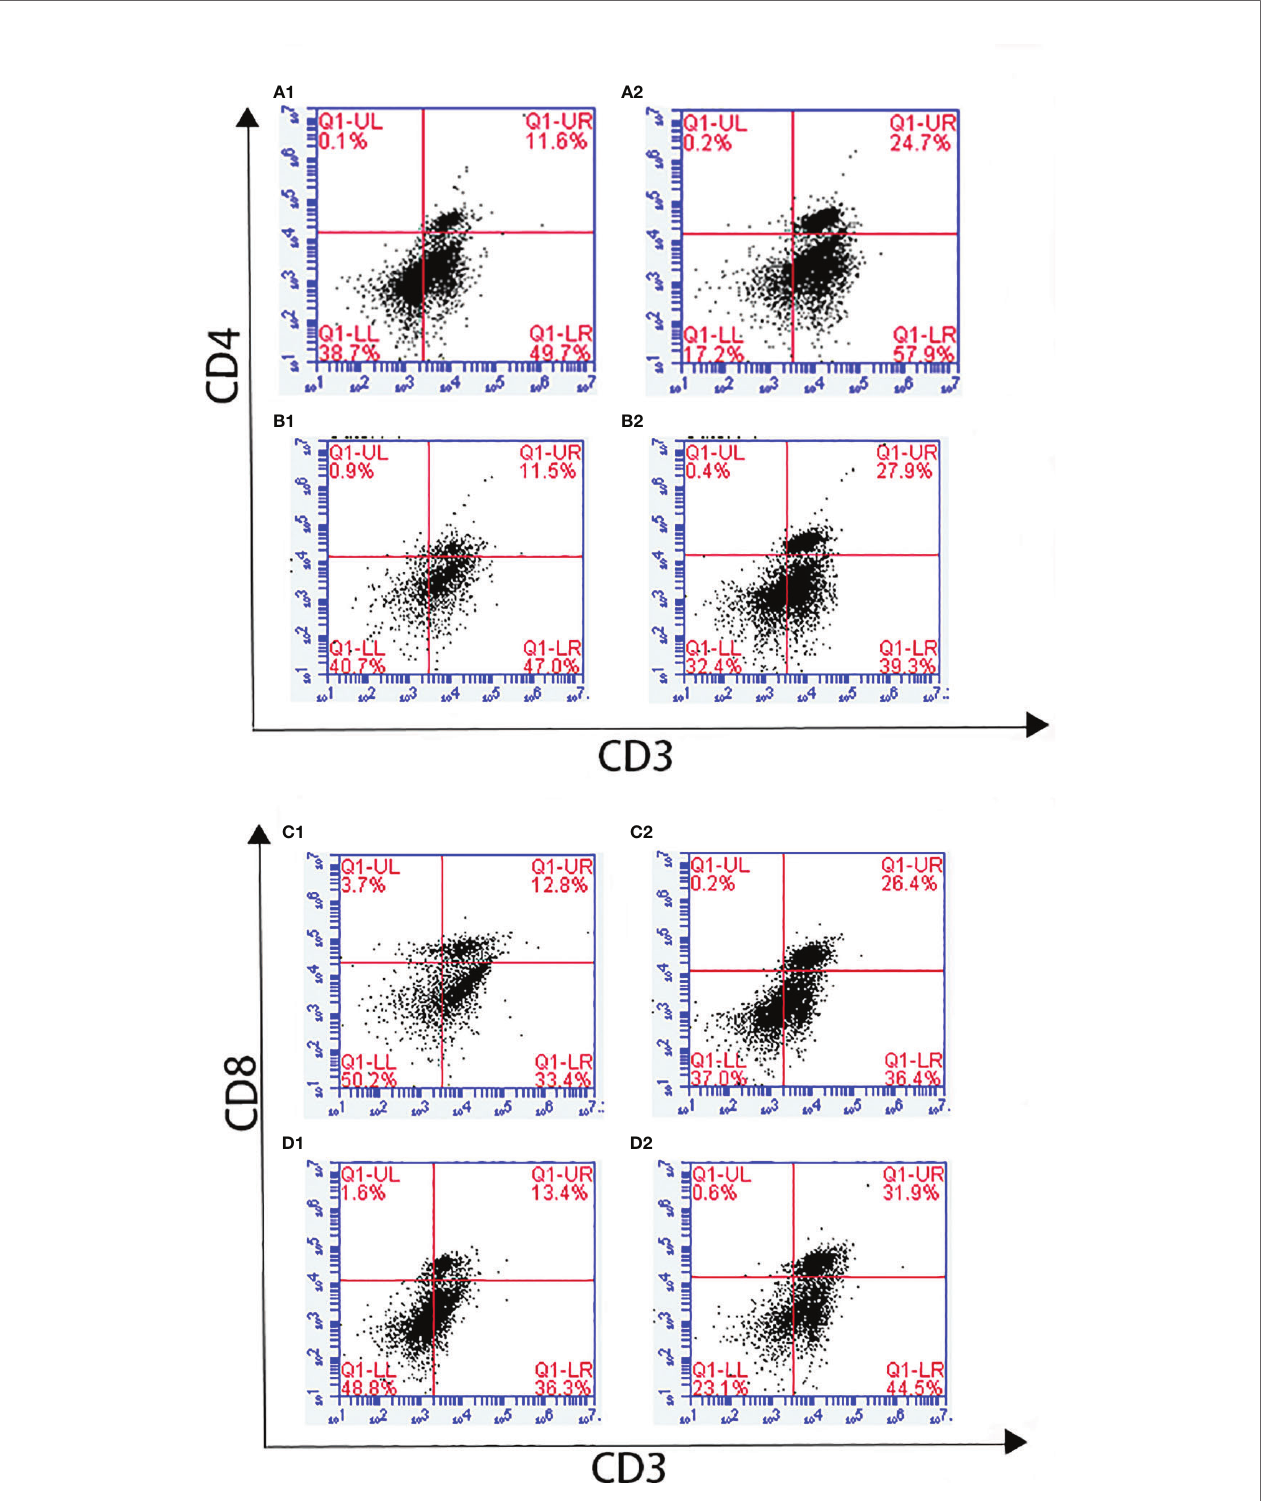
FIGURE 6 | The proportion of T lymphocyte subset in spleen of pET-28a-EmARM- b immunized chickens. (A) Determination of CD4 + /CD3 + T lymphocyte in immunized chicken spleen at 21 days old. (B) Determination of CD4 + /CD3 + T lymphocyte in immunized chicken spleen at 28 days old. (C) Determination of CD8 + / CD3 + T lymphocyte in immunized chicken spleen at 21 days old. (D) Determination of CD8 + /CD3 + T lymphocyte in immunized chicken spleen at 28 days old. 1: PBS (negative control). 2: The ratio of T lymphocytes in spleens from chickens immunized with recombinant protein pET-28a-EmARM- b